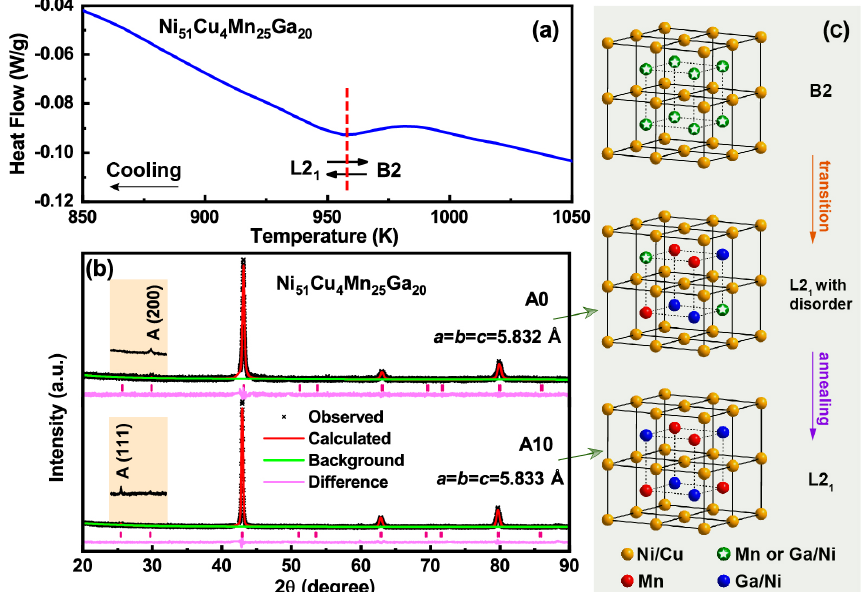
Figure 5. ( a ) Differential thermal analysis (DTA) curve of water quenched Ni 51 Cu 4 Mn 25 Ga 20 alloy upon cooling. ( b ) X-ray diffraction (XRD) spectra of water quenched and 10-h annealed Ni 51 Cu 4 Mn 25 Ga 20 alloys measured at 673 K. Insets show the XRD profile from 24 ◦ to 32 ◦ . ( c ) A schematic illustration for the crystal structure evolution of atomic order degree after quenching and annealing treatment. Ni/Cu, Mn and Ga/Ni in different occupied sites are represented by yellow, red and blue spheres respectively. And the green balls with a pentagram indicates the random occupation of Mn and Ga/Ni atoms. (For interpretation of the references to color in this figure legend, the reader is referred to the web version of this